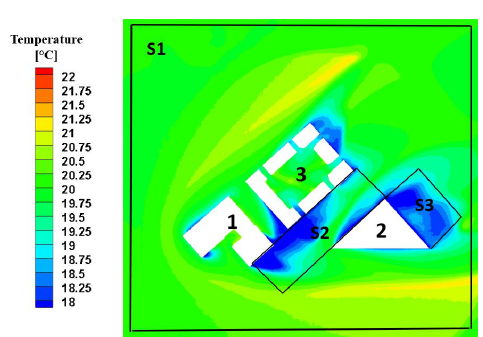
Figure 5. Regions S1, S2 and S3: Area-weighted average for temperature, concentration and velocity.